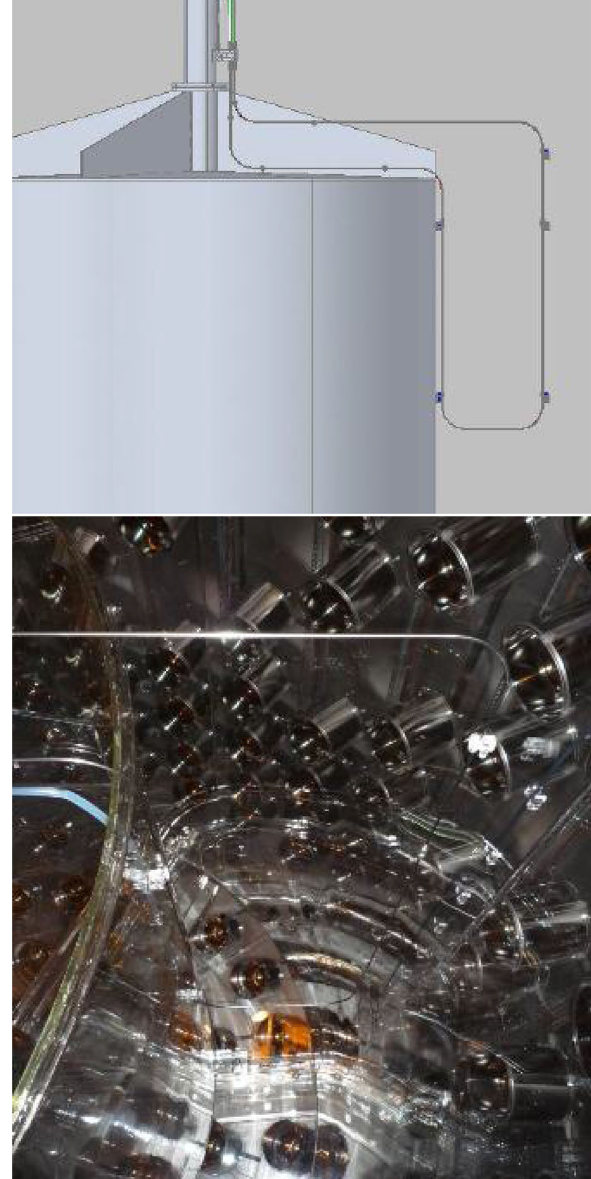
Fig. 25 The guide tube system used to calibrate the detector in the top half of the GC